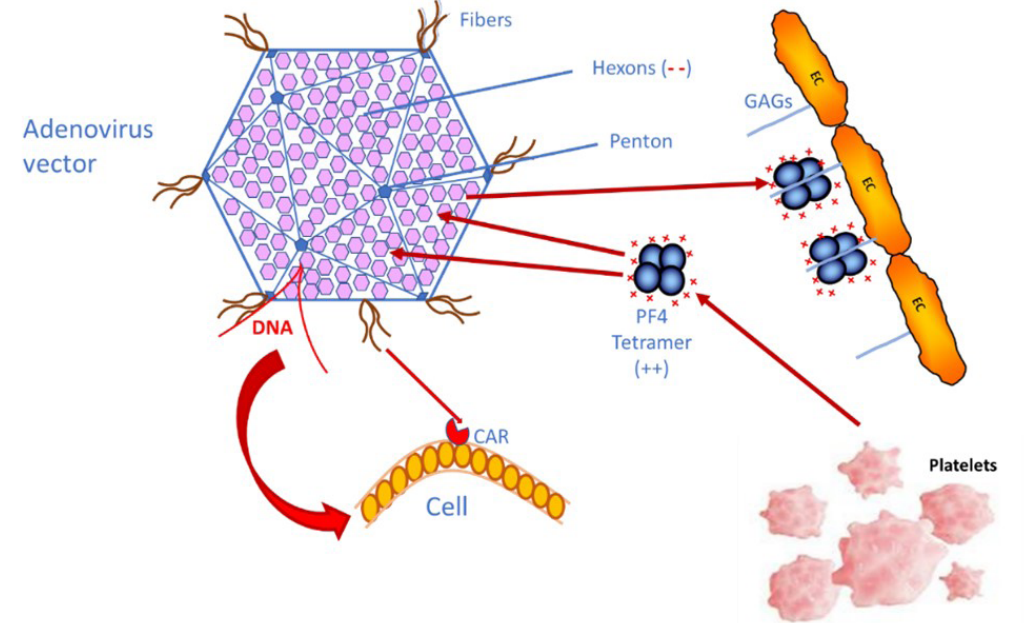
Figure 1. Simplified schema showing how the adenovirus vector used for DNA vaccines can enter human cells through the binding to CAR, and how PF4 could react with the hexon motives, through electrostatic interactions, if both come into accidental contact. PF4 is either released from platelet α-granules upon activation or can be released from the endothelial pool, where PF4 binds to endothelial cells (ECs) glycosaminoglycans (GAGs). (--): electronegative charges on GAGs; (++): electropositive charges on